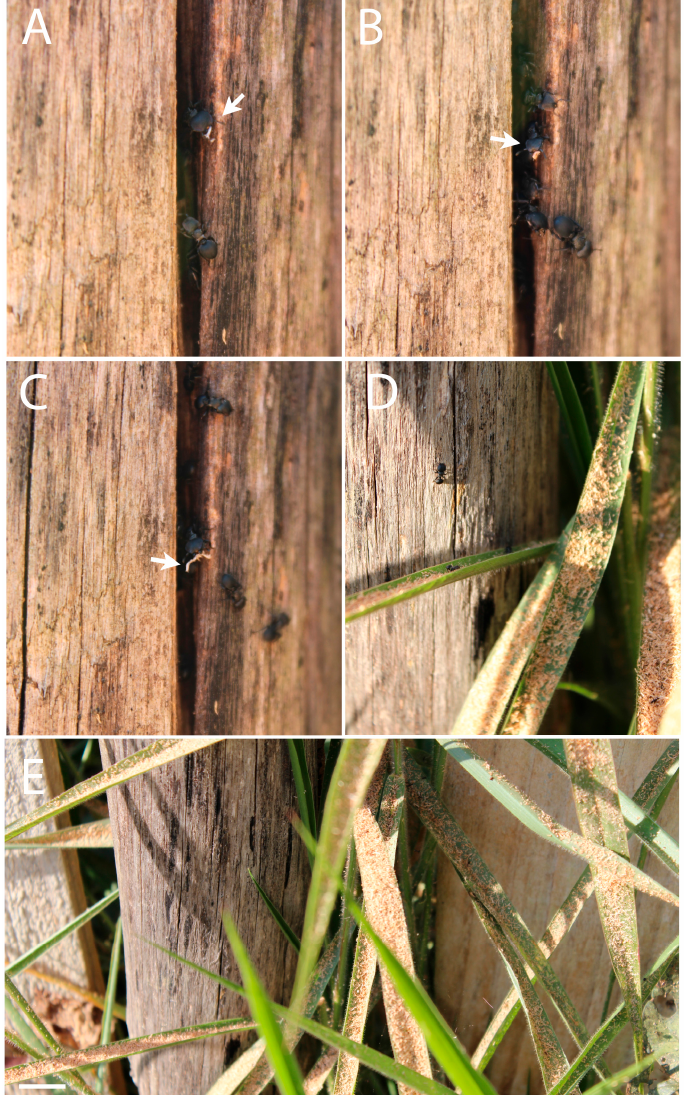
Figure 3. Cephalotes pusillus digging behavior records. ( A – C ) Workers unloading the small fragments of wood or sawdust; ( D , E ) accumulation of sawdust thrown away by the workers above the vegetation under nest.